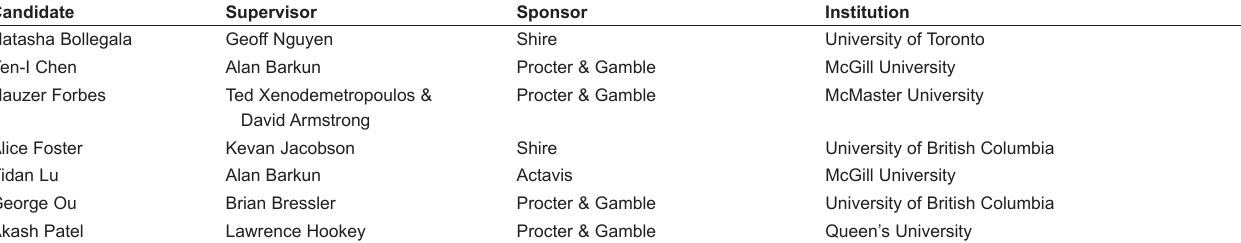
TAble 2 Funded Postdoctoral Fellowships (2014) TAble 4 Canadian Association of Gastroenterology- and Crohn’s & Colitis Canada-funded Summer Studentships (2014) Candidate